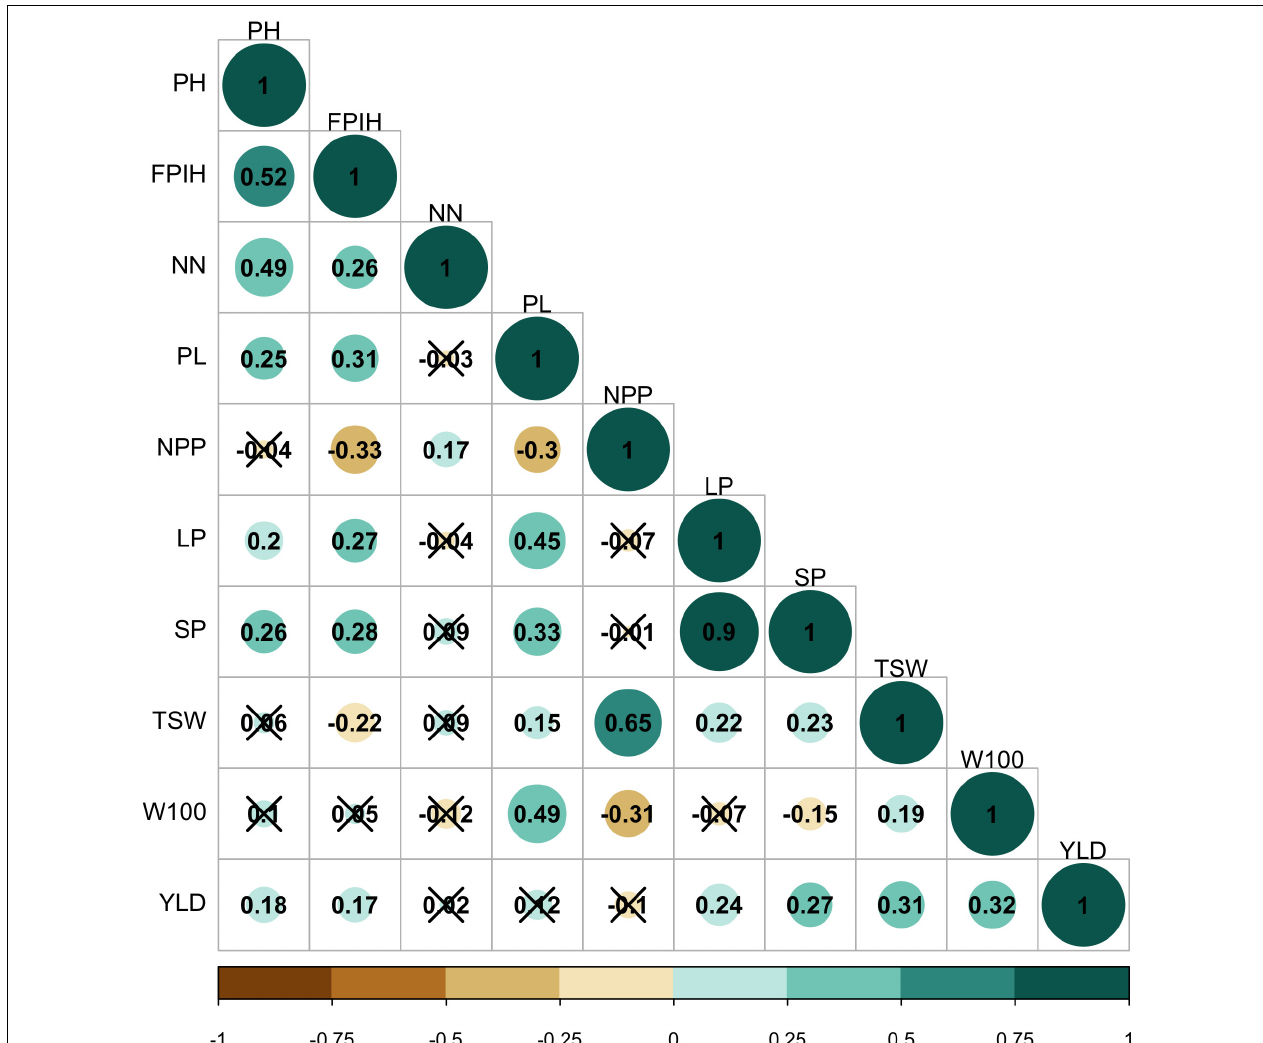
FIGURE 2 | Pearson’s correlation analysis for morpho-agronomic traits of a common bean accession belonging to the Brazilian Diversity Panel (BDP). (X), not significant at 5% probability level. PH, plant height (cm); FPIH, first pod insertion height (cm); NN, number of nodules; PL, pod length (cm); NPP, total number of pods per plant; LP, number of locules per pod; SP, number of seeds per pod; TSW, total seed weight per plant (gm); W100, 100-seed weight (gm); YLD, grain yield (kg.ha − 1